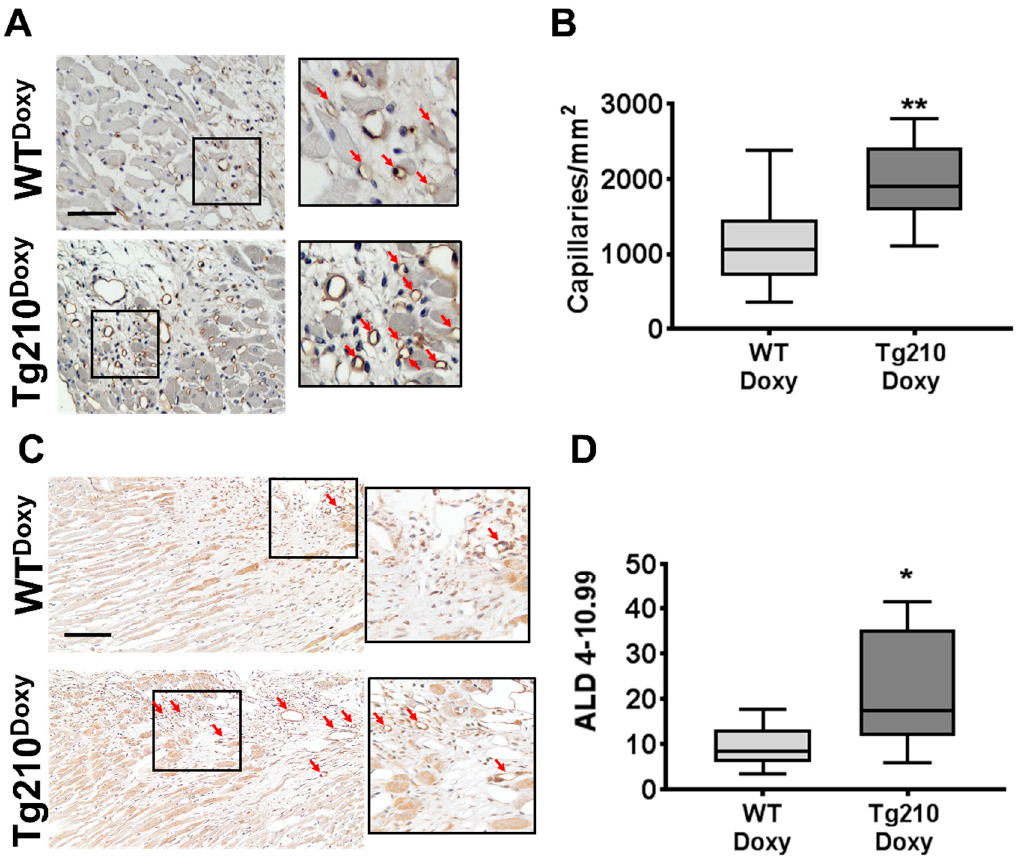
Figure 4. MiR-210 expression improves capillary density and arteriolar length density after MI. Morphometric analysis of capillaries and arteries after MI is shown. ( A ) Representative images of the border zone of the heart 1 month after MI, stained by Lectin immunohistochemistry. The magnification is shown at 400 × , and the calibration bar at 50 µ m. The inset shows a higher magnification; red arrows indicate capillaries. ( B ) The box plot shows quantification of capillaries / mm 2 carried out in the peri-infarct region of WT Doxy and Tg210 Doxy hearts ( n = 9 ** p < 0.009). ( C ) Representative images of the border zone of the heart 1 month after MI, stained by α SMA immunohistochemistry. As expected in failing hearts, some α SMA expression was observed also in cardiomyocytes. Magnification is shown at 200 × , and the calibration bar at 100 µ m. The inset shows a higher magnification; red arrows indicate arterioles. ( D ) The box plot shows quantification of ALD carried out in the peri-infarct region and in the scar of WT Doxy and Tg210 Doxy hearts ( n = 8–9 * p < 0.01).